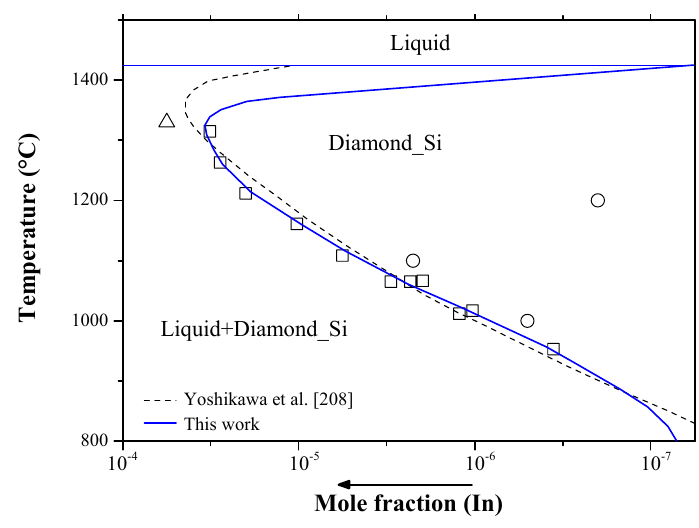
Figure 22. Magnified part of the In-Si phase diagram; -----: [208]; □ : [204]; ○ : [200]; Δ : [198].